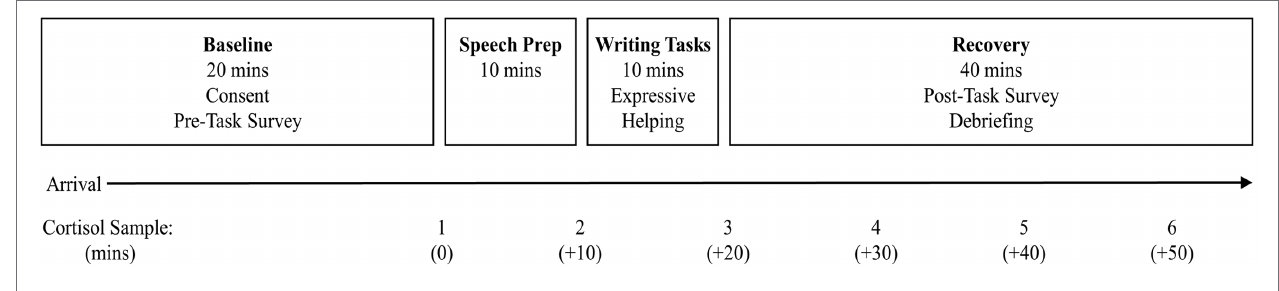
FIGURE 2 | Experimental and cortisol collection